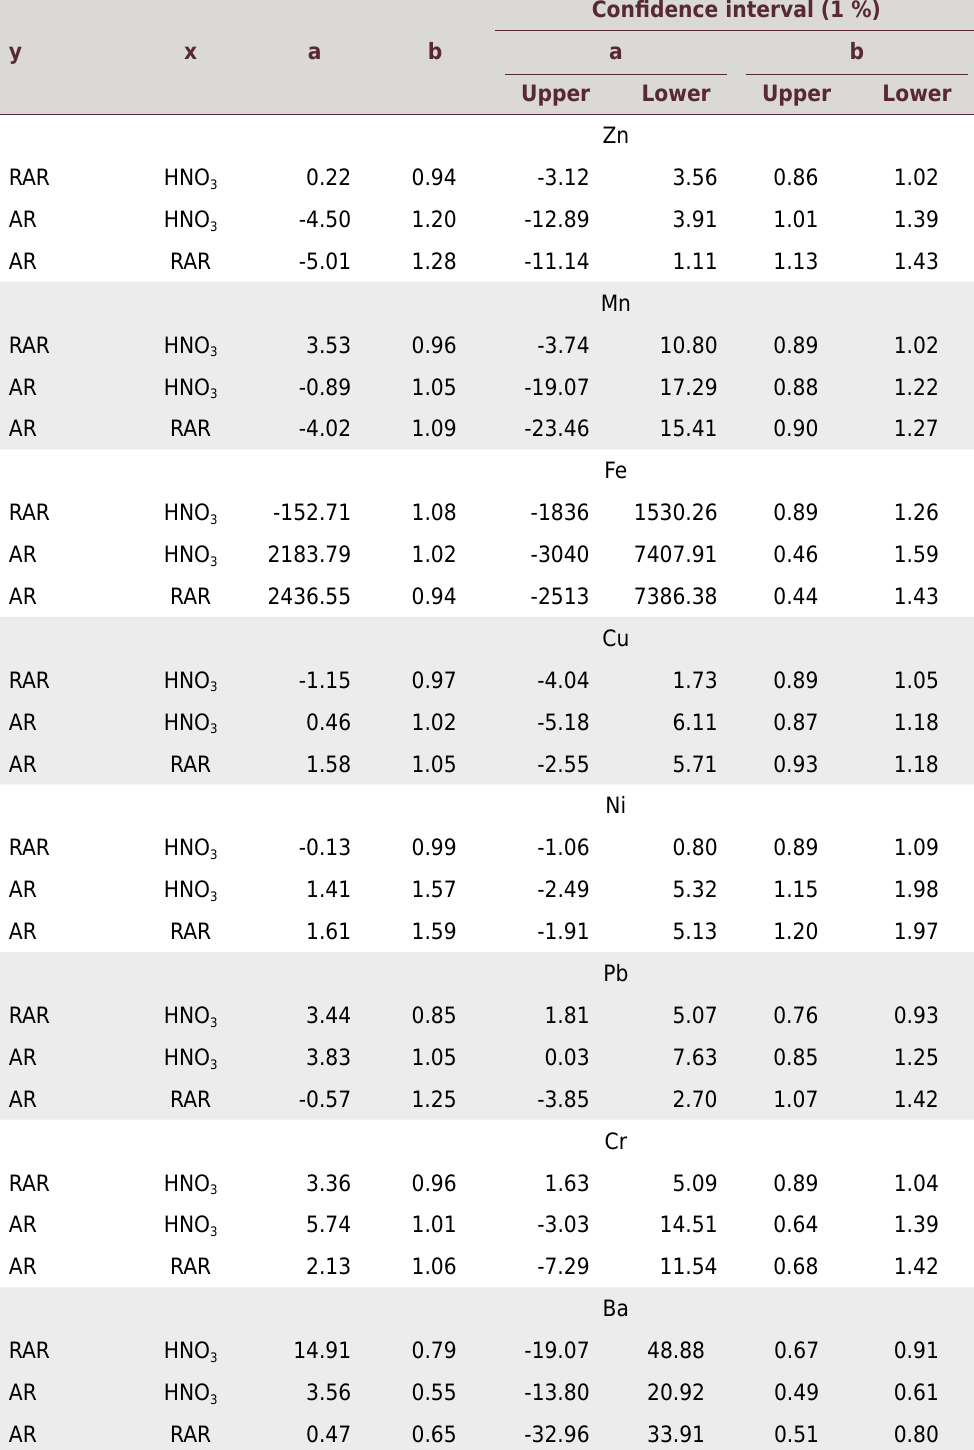
Table 4. Parameters associated with the linear regressions of the three digestion methods studied for Ba, Cr, Cu, Fe, Mn, Ni, Pb and Zn